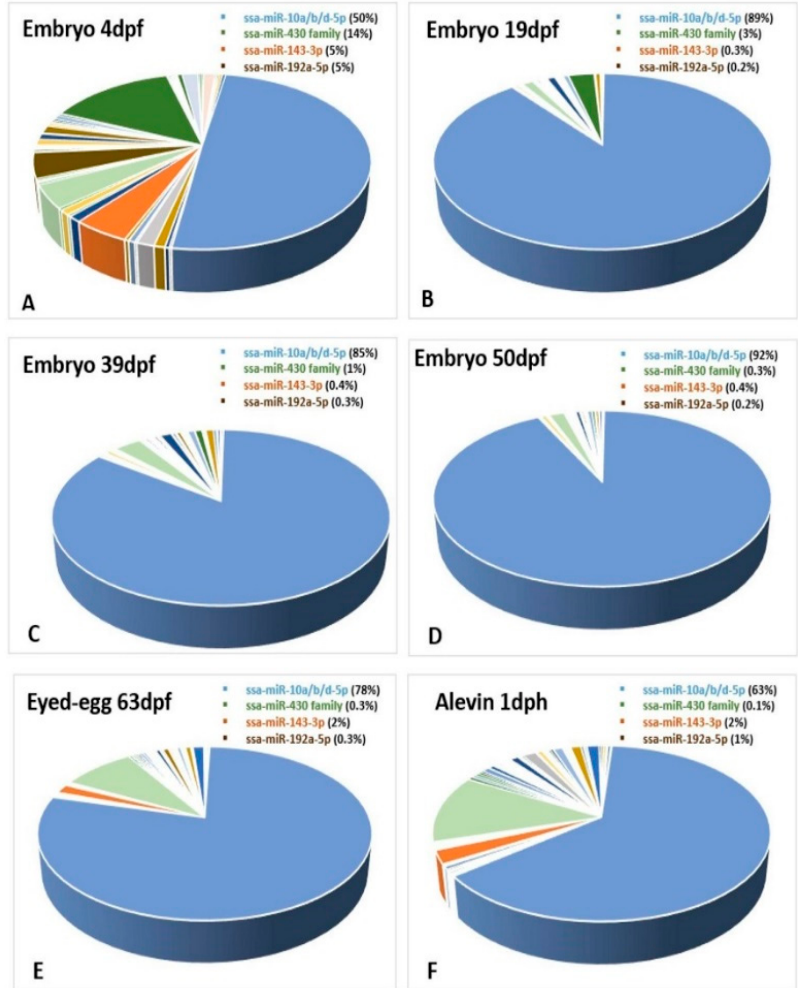
Figure 7. Abundance as a proportion of the total number of miRNAs within each of the developmental stages. The ssa-miR-10a/b/d-5p family, the miR-430 family, ssa-miR-143-3p and ssa-miR-192a-5p are shown in blue, green, orange and brown colors, respectively, in the figures ( A – F ).